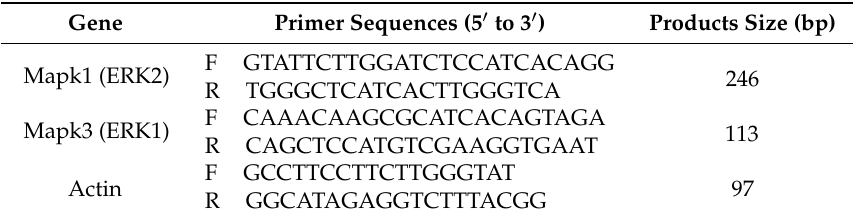
Table 2. The primer sequences used for